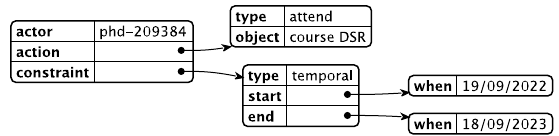
Figure 4: Instantiation of the rule called “Core courses” with the actual student id, and start and end date